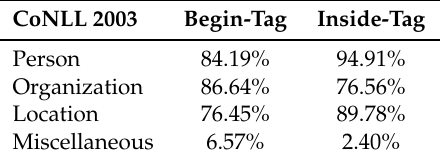
Table 6. The coverage of the dictionary on the CoNLL2003